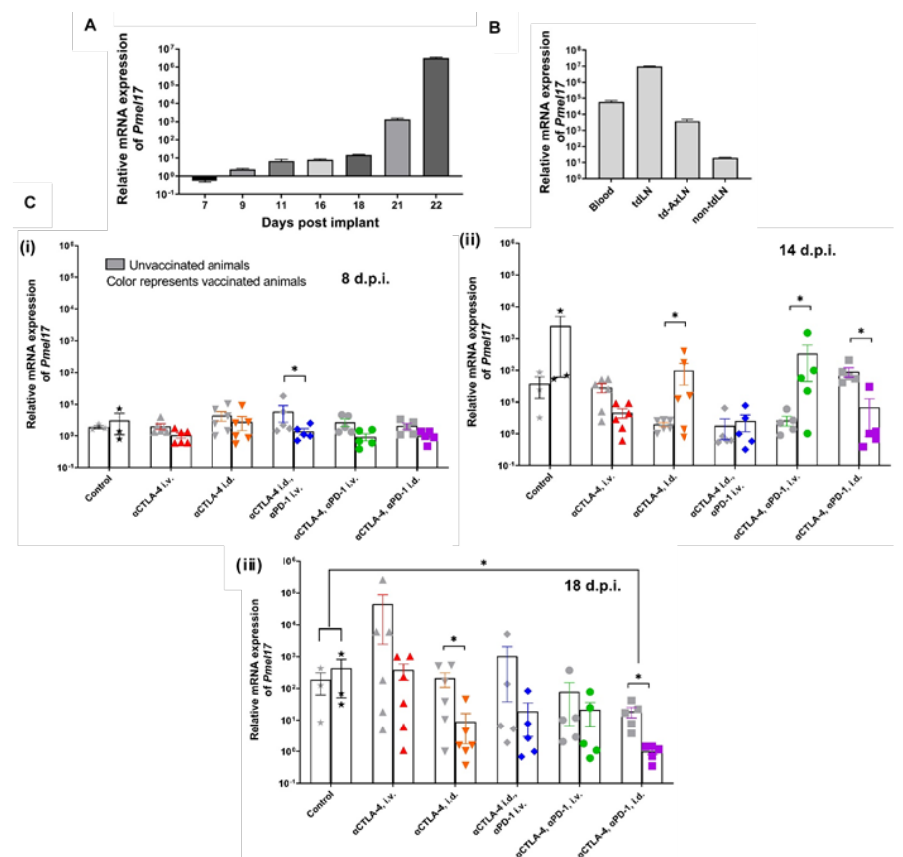
Figure 9. Metastatic burden in a dorsal foot implant model and response to CBIs in vaccinated and unvaccinated animals. ( A ) Transcriptomic levels of Pmel17 in blood increases during tumor progression. ( B ) Transcriptomic levels of melanoma marker Pmel17 in blood and LN at 11 days post implant (d.p.i.) coincides with visible metastasis ( n = 5). ( C ) Relative mRNA expression of Pmel17 in blood at (i) 8 d.p.i., (ii) 11 d.p.i., and (iii) 18 d.p.i. for vaccinated (denoted by colored symbols) and unvaccinated animals (denoted by grey symbols). * Denotes statistical significance by unpaired, two-tailed Student’s t test ( p < 0.05). Error bars indicate SEM. tdLN, tumor draining lymph node; td-AxLN, tumor draining axillary lymph node; non-tumor draining lymph node (non-tdLN); i.d. intradermal; i.v. intravenous.